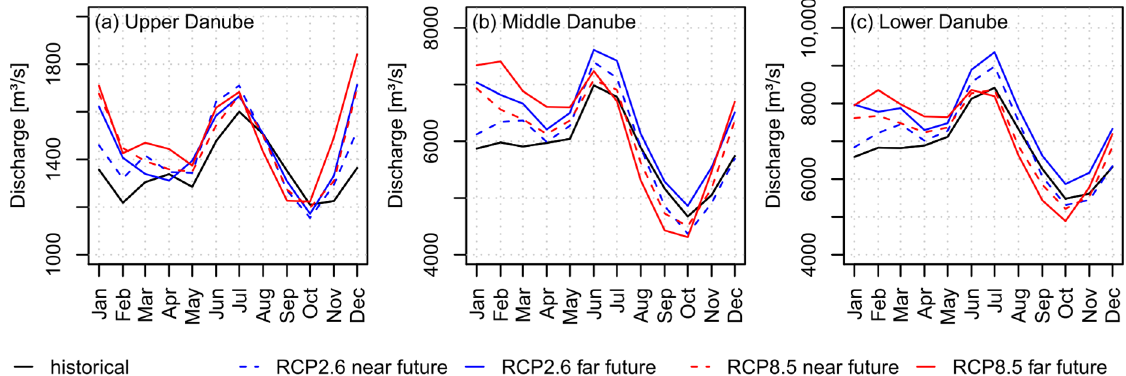
Figure 12. Long-term mean monthly developments of discharge [m 3 /s] according to the historical GCM-RCM-driven simulations (ensemble mean, 1971–2000) and the GCM-RCM-driven simulations (ensemble mean) under RCP2.6 and RCP8.5 for the near future (2031–2060) and the far future (2071–2100) for the Upper Danube at gauge Achleiten, the Middle Danube at gauge Iron Gate and the Lower Danube at gauge Ceatal Izmail.